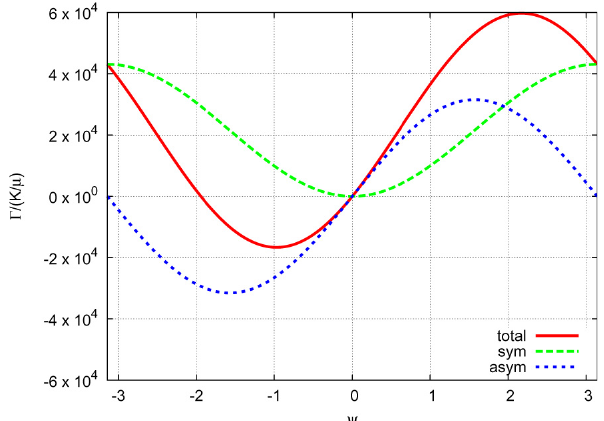
Fig. 4. The phase coupling function as a function of phase, nor- malised by µ/k 12 = µ/k 21 for a weakly nonlinear oscillator. The parameters are set to (V p ,g,A,B,L) = (3 . 17 × 10 − 9 ms − 1 , 5 . 00 × 10 6 Nm − 3 s, 1 . 50 × 10 5 Nm − 2 , 2 . 20 × 10 5 Nm − 2 , 1 . 00 × 10 − 2 m). The blue, green, and red curves are the antisymmetric part defined by Eq. (49), symmetric part by Eq. (55), and total by Eq. (35), re-